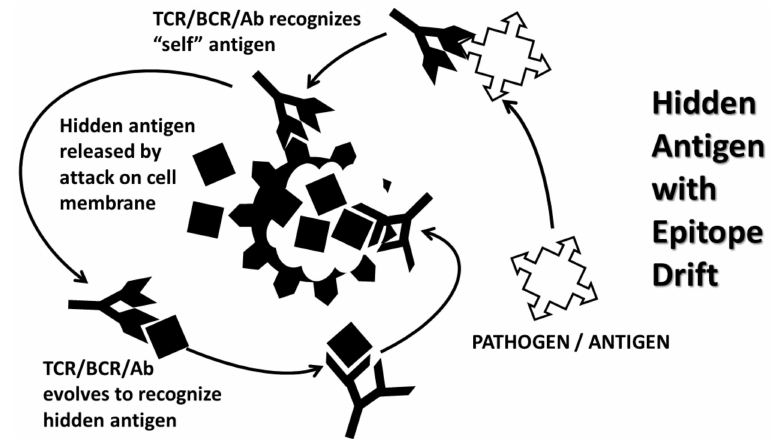
Figure 4. Schematic diagram of the hidden antigen theory (HAT) at work with epitope drift (ED). HAT can be initiated theoretically by any of three mechanisms. One would be mechanical or chemical harm to cells causing them to release hidden or “cryptic” antigens to which the immune system has not been tolerized during development. It may also be initiated by either MMT (Figure 2) or AIT (Figure 3) if cellular damage releases such hidden antigens. To illustrate how HAT may be integrated with other AD theories, it is illustrated here with MMT as the initiator followed by ED. The process begins with a pathogen or other antigen that mimics some extracellular host antigen. Antibody or T-cell mediated immunity cross-reacts with host cells bearing the antigenic mimic, releasing intracellular hidden antigens. These hidden antigens may be unrelated to the initiating pathogenic antigen and induce an entirely new immune response or the hidden antigens may also be mimics of either the pathogenic antigen or the original host mimic. In the latter case, the existing immune response may evolve to recognize more highly antigenic determinants (epitopes) on the hidden antigen, driving a more severe autoimmune response. The latter process is called epitope